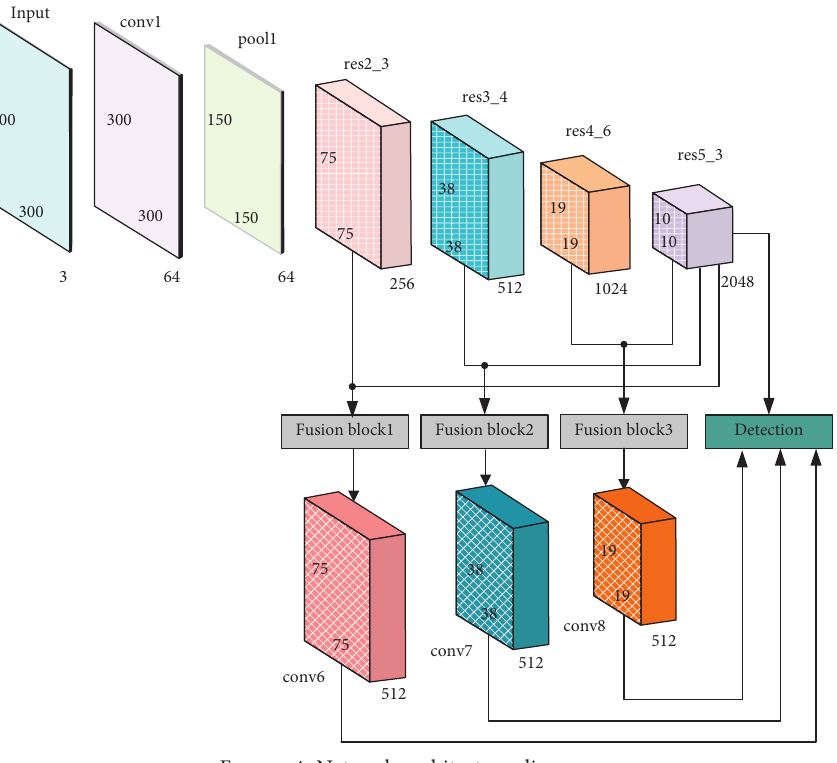
Figure 4: Network architecture diagram.